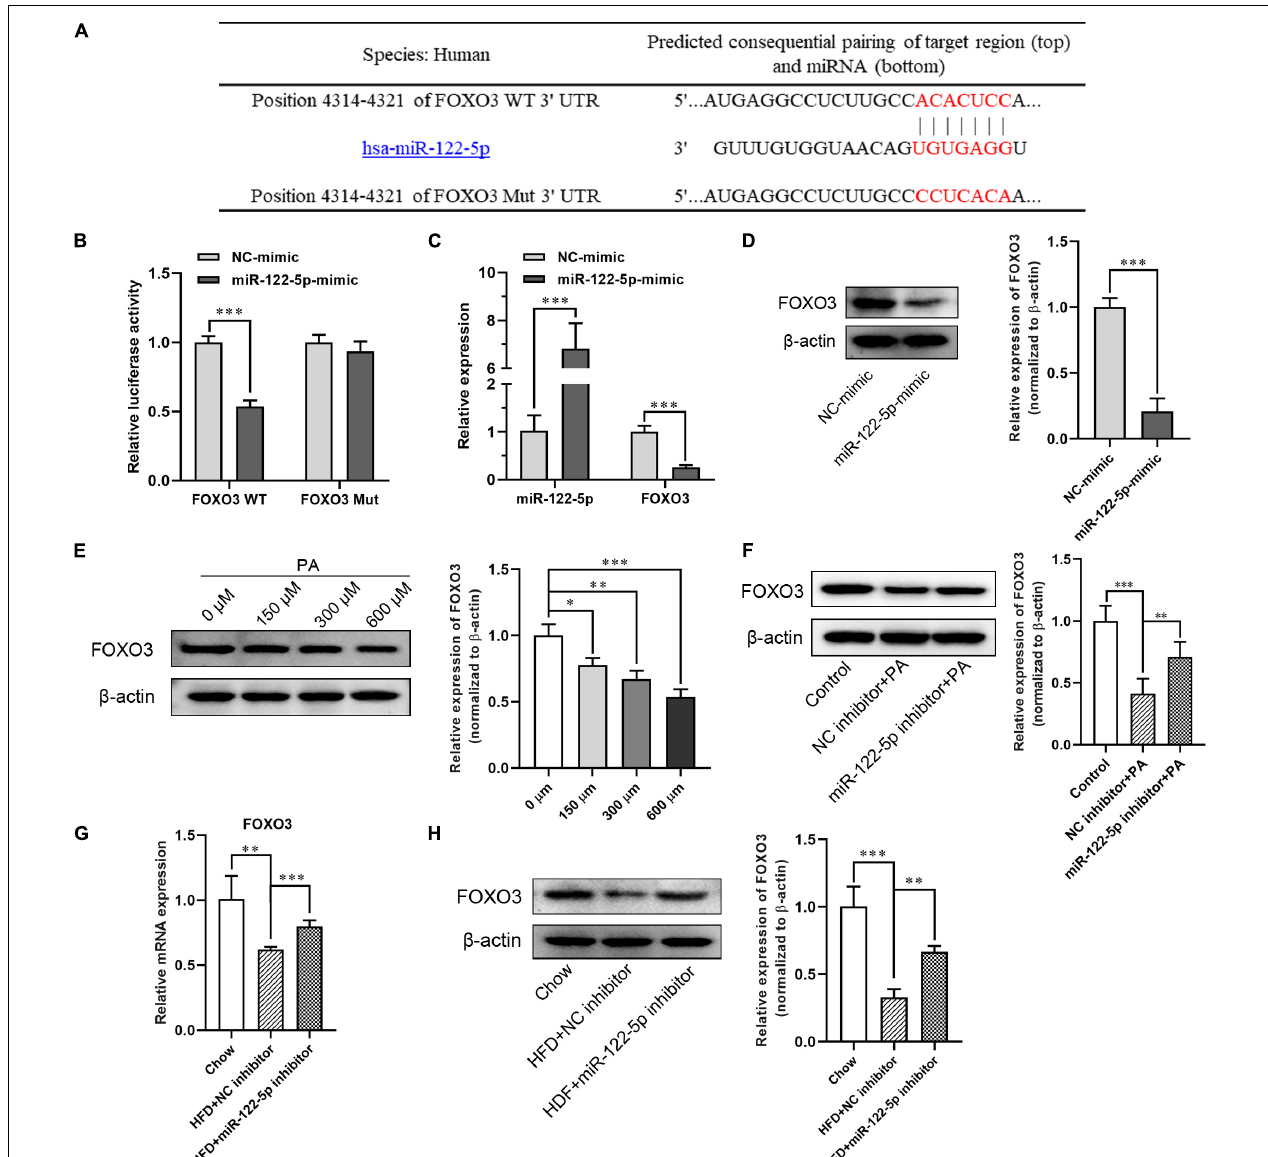
FIGURE 4 | MiR-122-5p directly inhibits FOXO3 expression in L02 cells and hepatic tissues in obese mice. (A) Matched sequence (red box) of with mature miR-122-5p and the FOXO3 WT. (B) Targeted binding of miR-22-5p and FOXO3 were detected by fluorescein reporter. (C) qRT-PCR analysis of miR-122-5p and FOXO3 expression in L02 cells after transfection with miR-122-5p mimic. (D) Western blot analysis of FOXO3 expression after transfection with miR-122-5p mimic. (E) Western blot analysis of FOXO3 expression in L02 cells treated with different concentrations of PA. (F) Western blot analysis of FOXO3 expression in L02 cells treated with miR-122-5p inhibitor. (G) qRT-PCR analysis of hepatic FOXO3 expression after injected with miR-122-5p inhibitor. (H) Western blot analysis of hepatic FOXO3 expression after injected with miR-122-5p inhibitor. Error bars indicate SD. ∗ P < 0.05, ∗∗ P < 0.01, ∗∗∗ P <